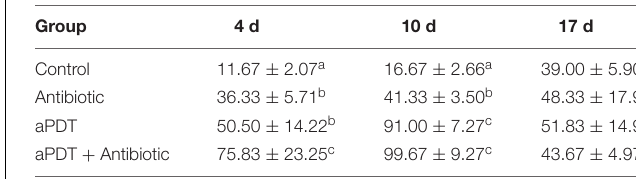
Frontiers in Microbiology |